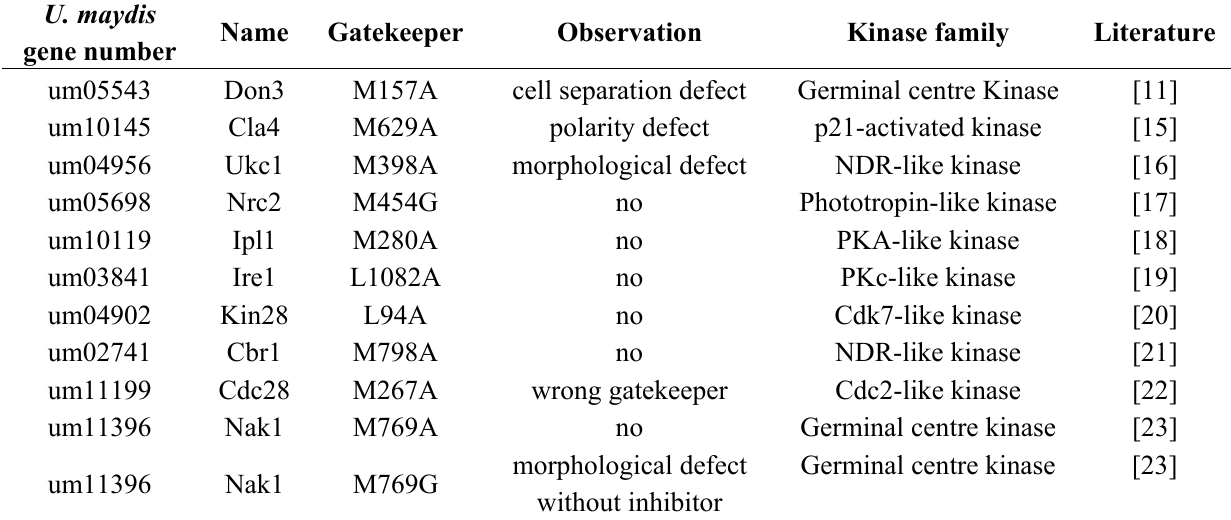
Table 2. Protein kinases used in the “Chemical genetic” courses